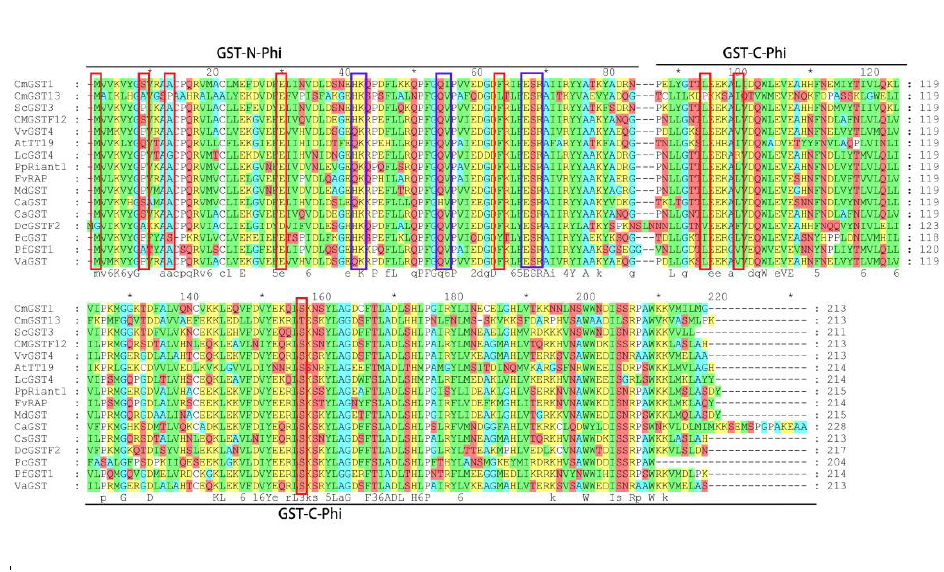
Figure 3. Multiple alignments of amino acid sequences for the CmGST1 and CmGST13 protein with other recognized anthocyanin-related GSTs. PpRiant1 (ALE31199), MdGST (NP_001315851.1), FvRAP (XP_004288578), LcGST4 (ALY05893), VvGST4 (AAX81329), VaGST (Vitis amurensis, ACN38271), CMGSTF12 (ABA42223), CsGST (Citrus sinensis, NP_001275781), CaGST (Capsicum annuum, XP_016562106), DcGSTF2 (Dianthus caryophyllus, BAM21533), ScGST3 (Senecio cruentus), AtTT19 (BAD89984), PfGST1 (Perilla frutescens, BAG14300), and PcGST (Pyrus communis, ABI79308). Red boxes indicated amino acid residues that had previously been recognized to be conserved in anthocyanin-related GST. Blue boxes indicated the regions that were involved in glutathione binding. Asterisks indicate a conserved amino acid